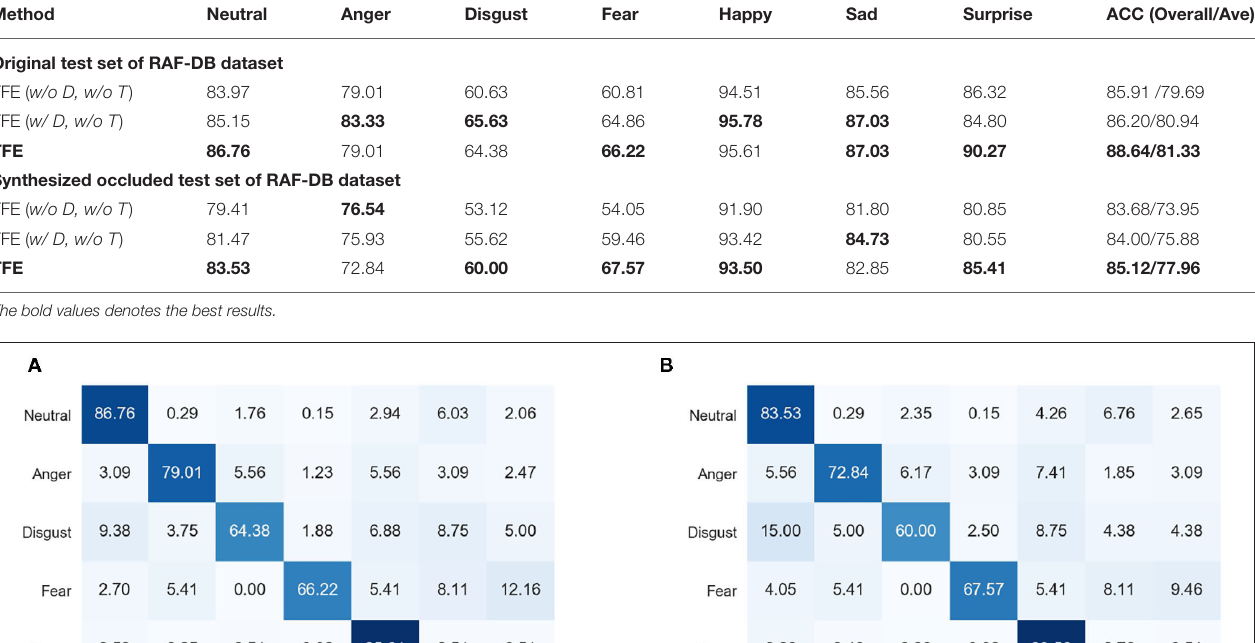
TABLE 4 | Ablation study on RAF-DB dataset. Method Neutral Anger Disgust Fear Happy Sad Surprise ACC (Overall/Ave)